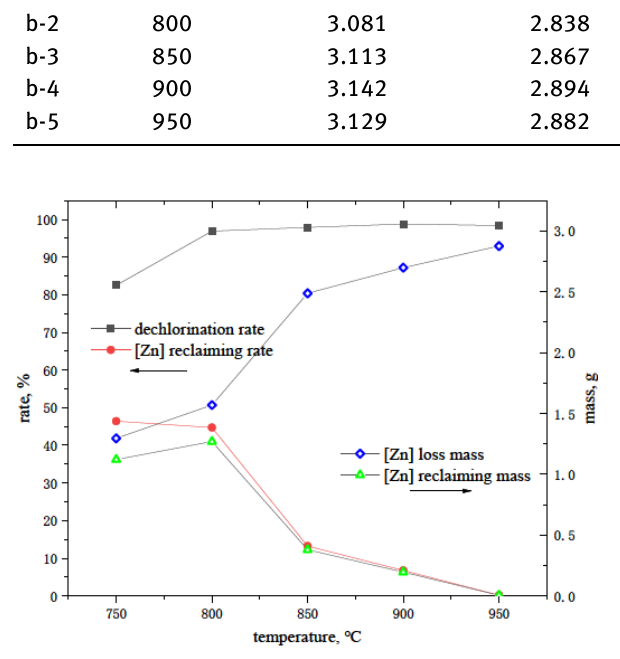
Figure 7: Results of dechlorination and [Zn] reclaiming with a chang- ing